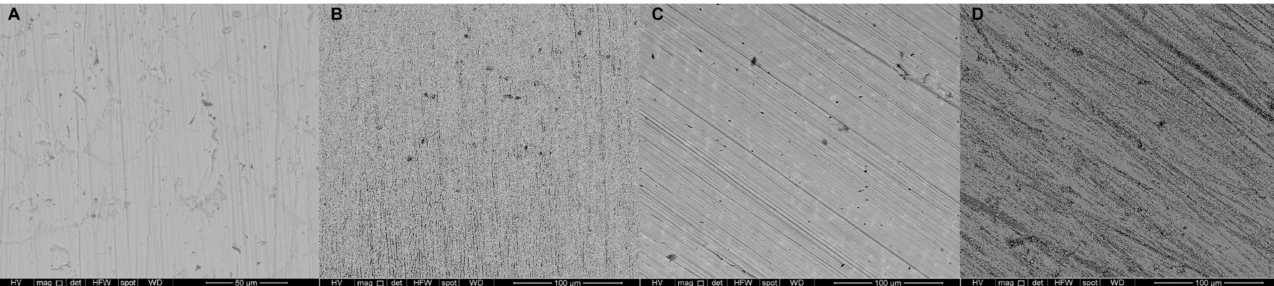
Figure 7. SEM images for ( A ) non-coated, ( B ) chemically coated, and ( C ) electrochemically coated Wirolloy with PVS, and ( D ) electrochemically nHAP coated alloy after immersion in artificial saliva for 14 days at 37 ◦ C. Reprinted with permission from: Ghoneim, A.A.; Abdellatif, A.; Ameer, M.A. Zeitschrift fur Anorg. und Allg. Chemie 2019 , 645